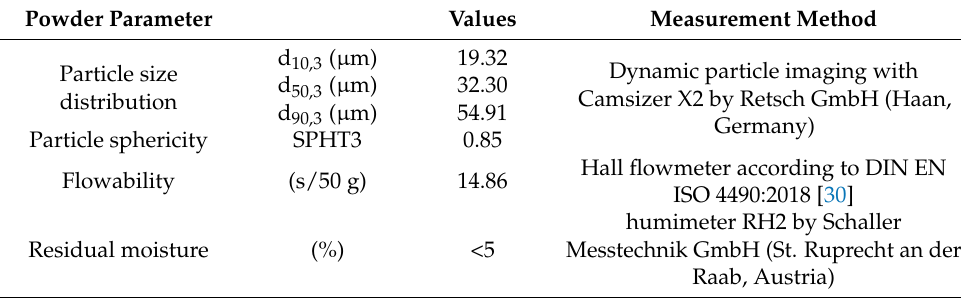
Table 2. Powder specification according to VDI 3405 Blatt